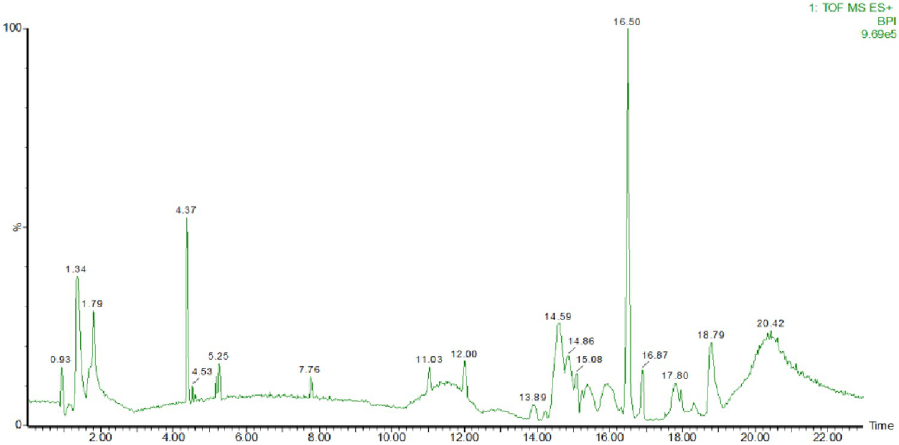
Fig 6. Chromatogram of L . inermis ethyl acetate extract obtained with LC MS/MS. A 1 mg/ml plant extract diluted in sterile ddH 2 O was used for phytochemical compound detection with LC